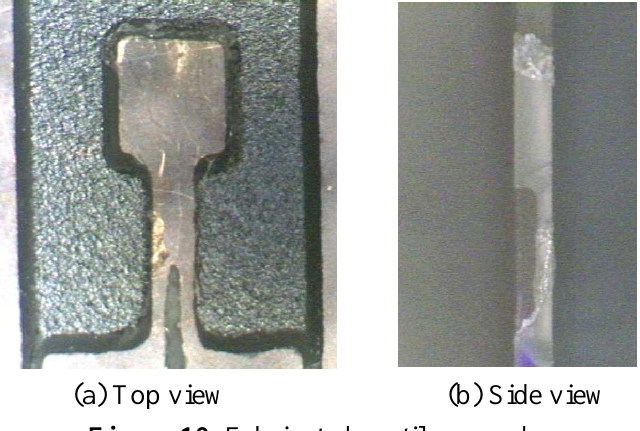
Figure 10. Fabricated cantilever and